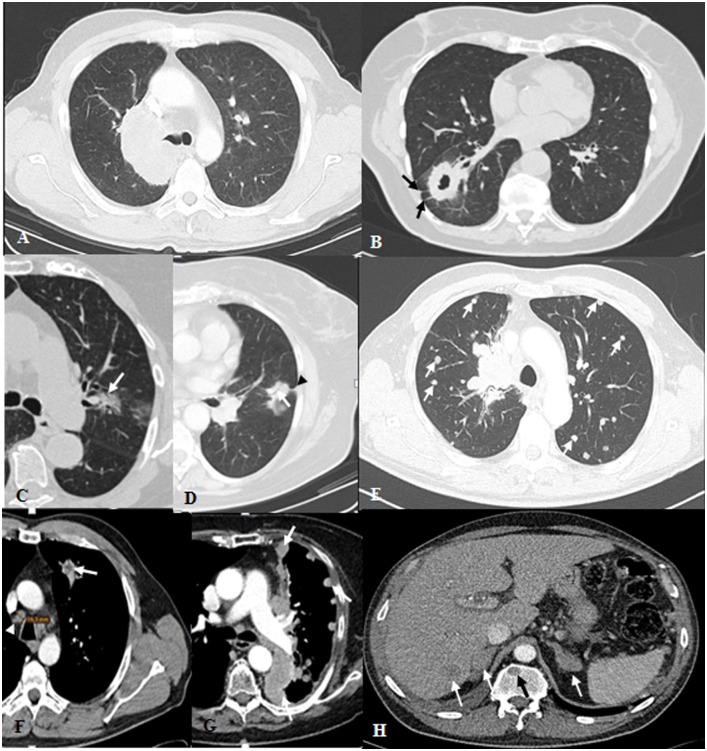
Transversal CT images of pulmonary adenocarcinoma with examples of the morphological features under investigation.(A) Central lesion with tumor-bearing lobe atelectasis; (B) peripheral cavitary solid mass with ovoid shape, predominant spiculated margins and associated pleural tags (arrow); (C) central irregular semi-solid lesion in smooth margin with air bronchogram (arrow), GGO account for 25%-50%; (D) peripheral lesion with irregular shape, air bronchogram (arrow) and pleural tag (arrowhead); (E) central solid lesion with irregular shape and predominant lobulated margins with bilateral pulmonary metastases (arrows); (F) Irregular shape tumor after contrast enhancement showed central necrosis (arrow) and contralateral mediastinal lymph node metastasis (arrowhead); (G) tumor-side pleural metastases (arrows); (H) liver, bone, and bilateral adrenal gland metastases (arrows).